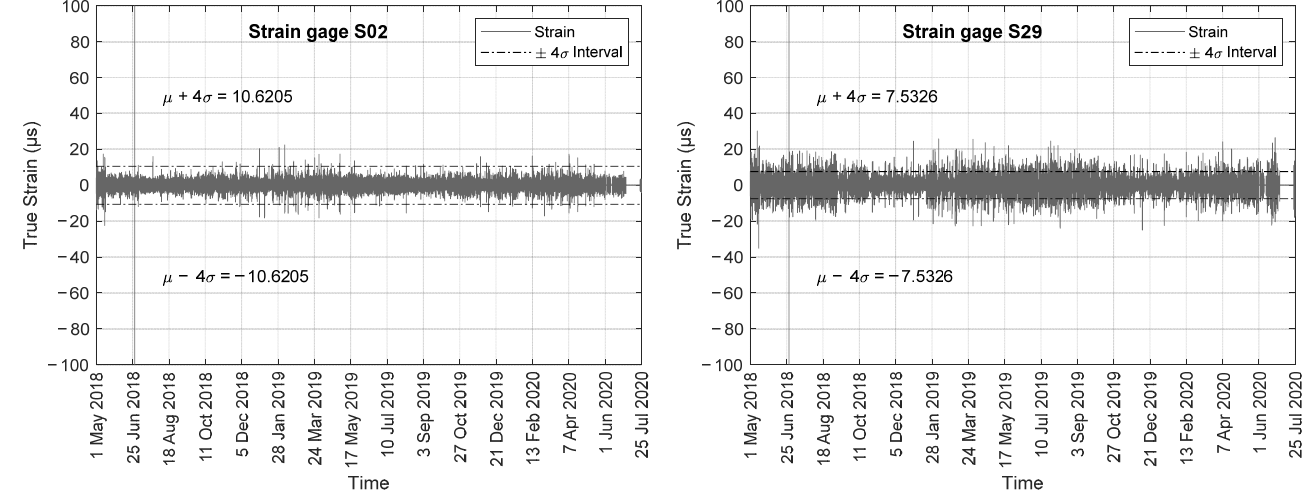
Figure 14. Cleansed true strain calculated as the difference between the raw strain and the moving averaged strain.